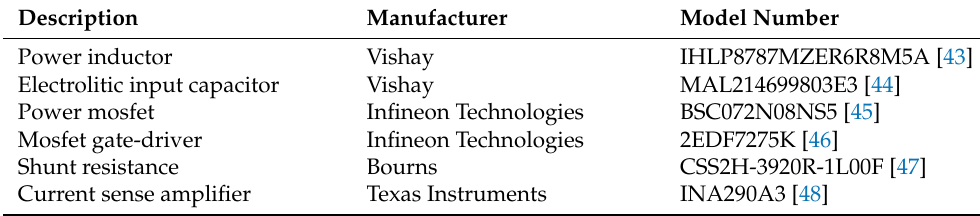
Table 3. Main electronic